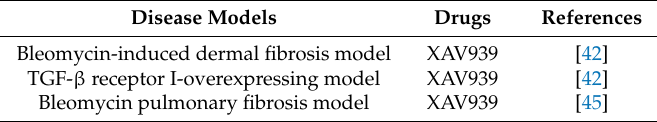
Table 2. Preclinical studies of tankyrase inhibitors with in vivo murine fibrosis models. Disease Models